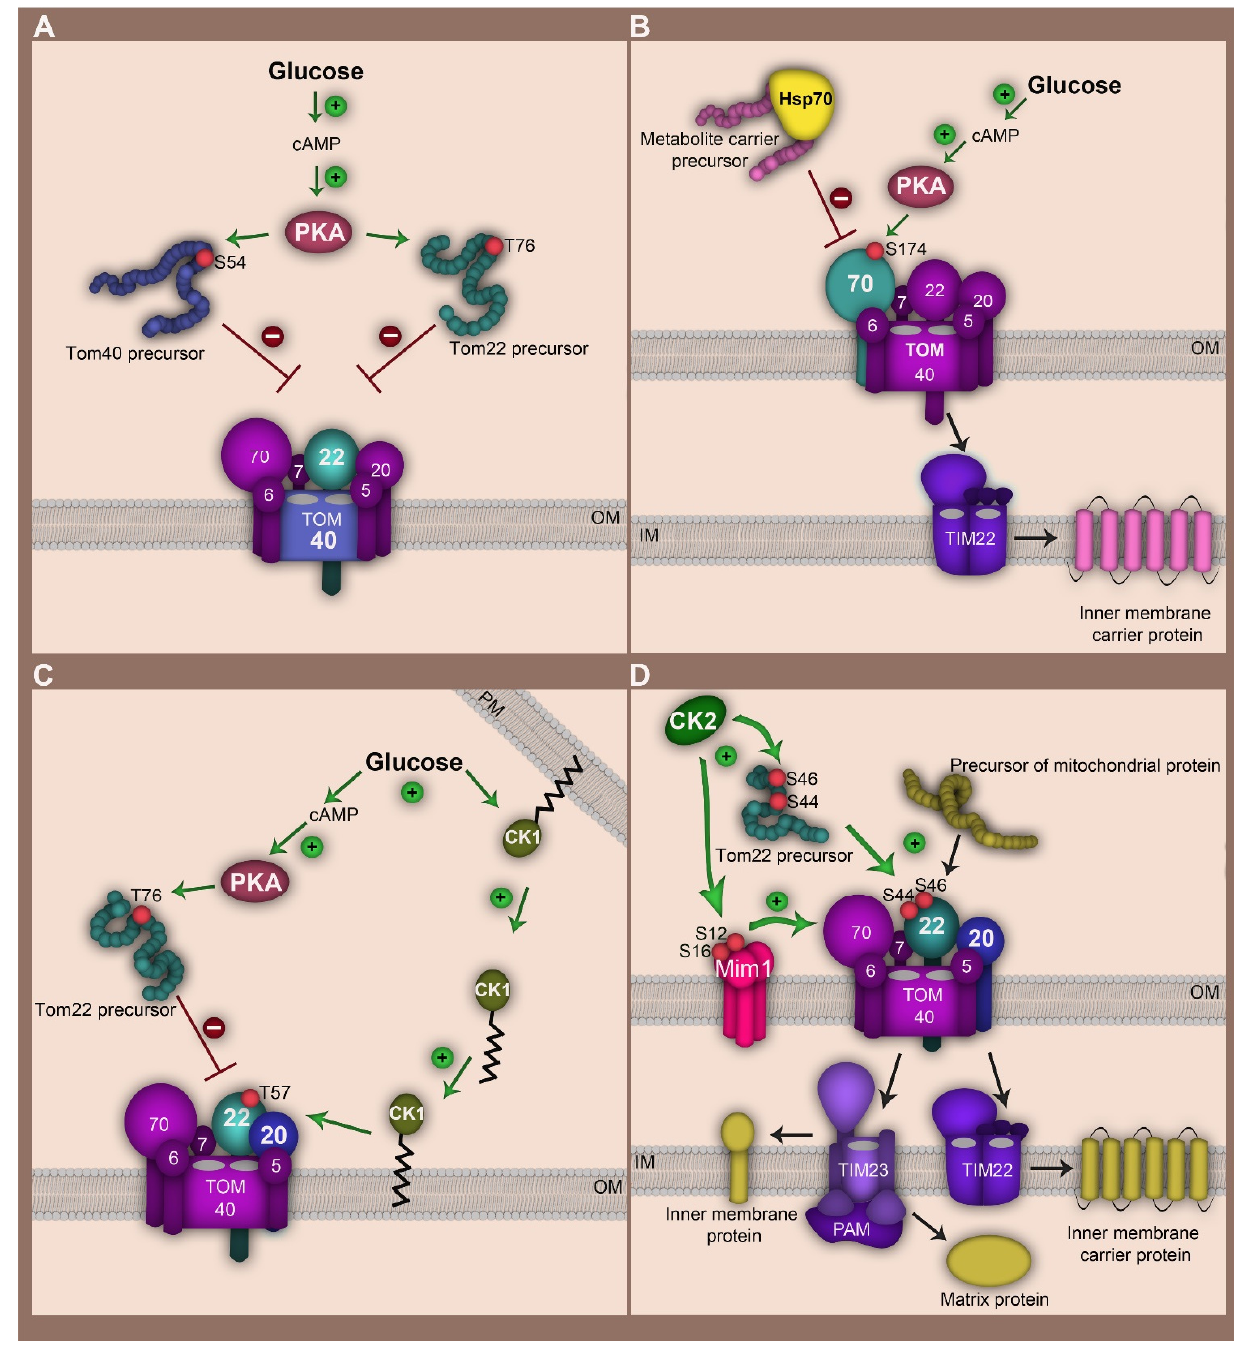
FIGURE 2: Regulation of the TOM complex by cytosolic and outer membrane bound kinases in the yeast S. cerevisiae . (A) Glucose induces an increase in cAMP synthesis and PKA activation. PKA phosphorylates Tom40 and Tom22 precursors in the cytosol at serine 54 and threo- nine 76, respectively. Translocation of phosphorylated precursors to the outer membrane and their assembly into the mature TOM complex is thereby impaired. (B) Glucose-driven activation of PKA inhibits import of metabolite carrier precursors. PKA phosphorylates the Tom70 receptor at serine 174. This modification impairs interaction of Tom70 with the metabolite carrier/chaperone complex. (C) Glucose signalling leads to retranslocation of CK1 from the plasma membrane (PM) to the mitochondrial outer membrane. CK1 targets threonine 57 at Tom22 promoting Tom22 assembly (by enhancing its interaction with Tom20). CK1 acts downstream of PKA thereby mitigating strong PKA activity. (D) CK2 exerts a stimulatory role on TOM complex biogenesis and activity. Phosphorylation of Tom22 precursor at serine 44 and serine 46 facilitates its interaction with Tom20 receptor and stimulates assembly of Tom20 into the TOM complex. In addition CK2 modifies serine 16 and serine 14 of Mim1 enhancing its stability and promoting Mim1-dependent import of Tom20 and Tom70 precursors. CK2 regulation of the TOM-complex thereby influences downstream import pathways. OM, mitochondrial outer membrane; IM, mitochondrial inner mem- OPEN ACCESS | www.microbialcell.com